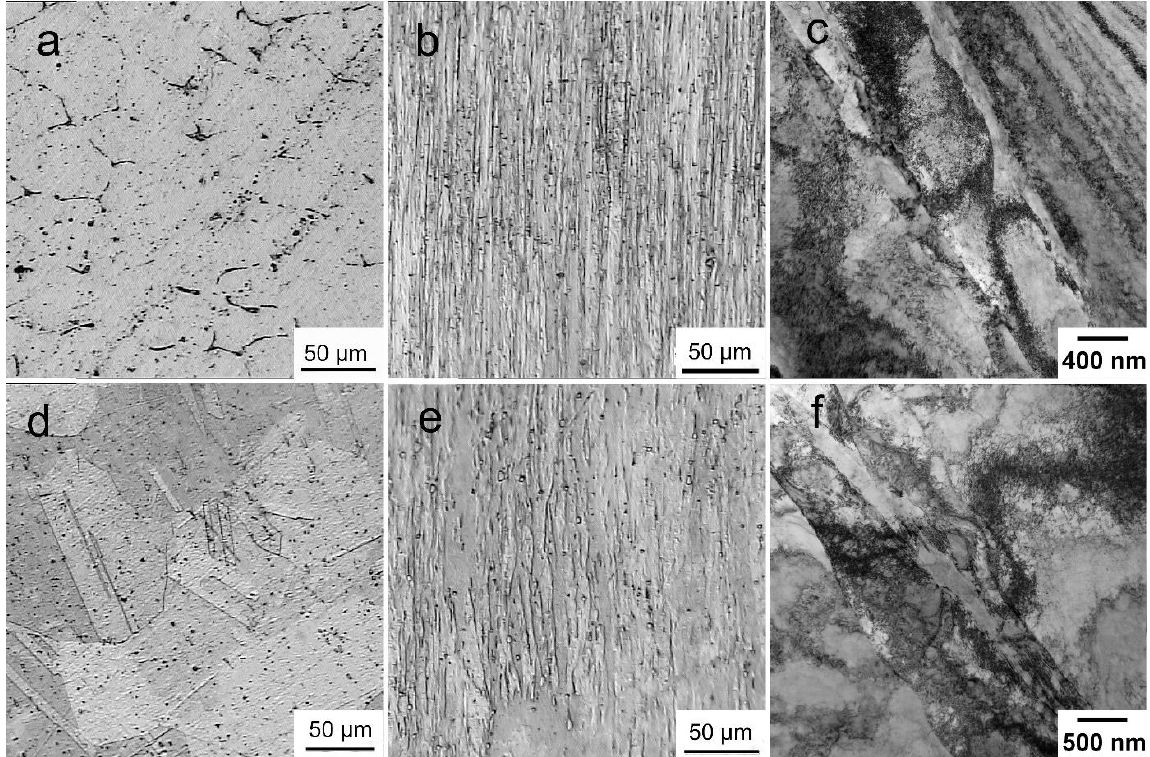
Figure 2. Microstructure of the Cu-0.5%Cr-0.08%Zr alloy in various states: ( a ) extrusion; ( b , c ) ex- trusion + RS; ( d ) quenching; ( e , f ) extrusion + quenching + RS